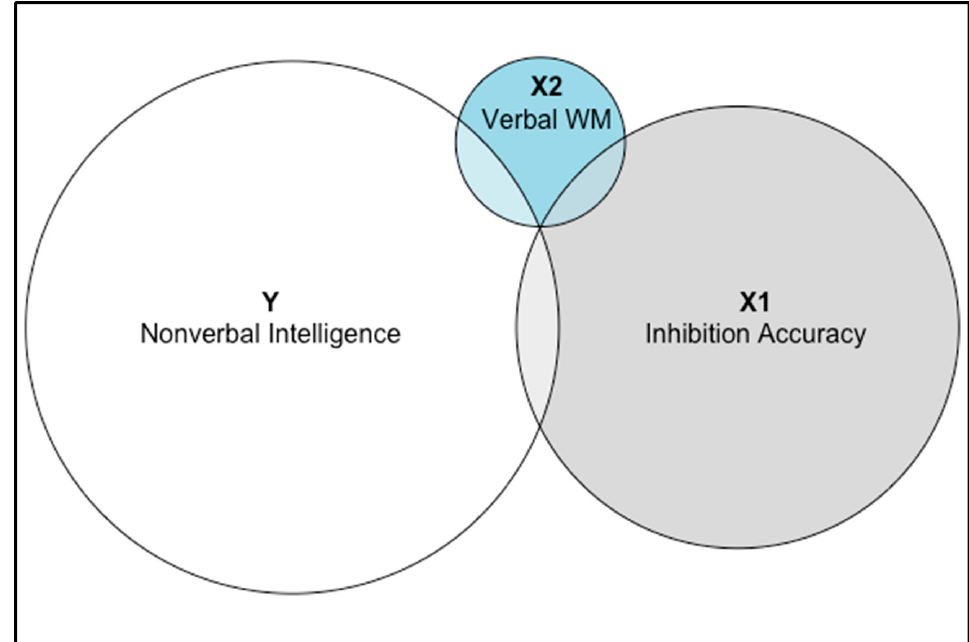
Figure 2. Correlation of accuracy in inhibition with intelligence ( a ) and verbal WM ( b ).